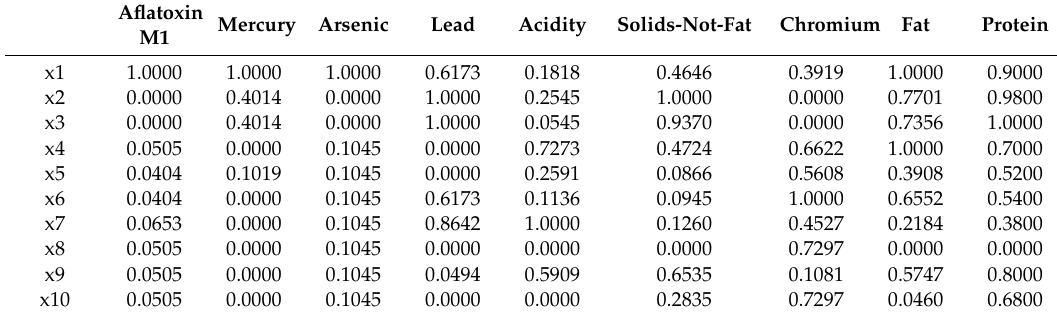
Table 5. Reordering the matrix according to the order of weight.